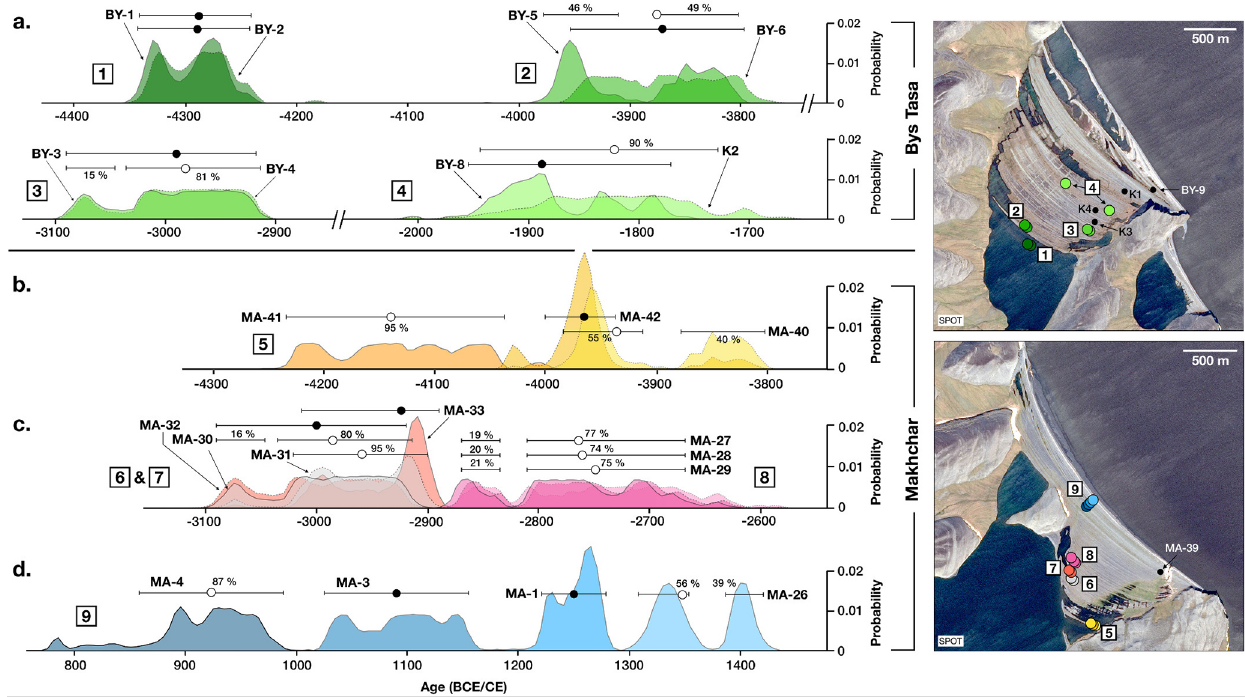
Figure 2. Comparison of the calibrated radiocarbon probabilities between the sample sets obtained from the field sites. Two sigma age ranges (95.4%) are indicated by the horizontal bar, and the location of the circle indicates the median age of the sample. Empty circles indicate probabilities < 95 . 4%, and the values are given above the respective bar. Probabilities < 10% are not displayed. The figure illustrates that most of the age indications obtained from samples at stratigraphically similar positions overlap almost entirely (a, b, c) , and that sensitive changes in coastal progradation can be captured by closely spaced samples (d) . Background image SPOT7; ©Airbus DS 2017.